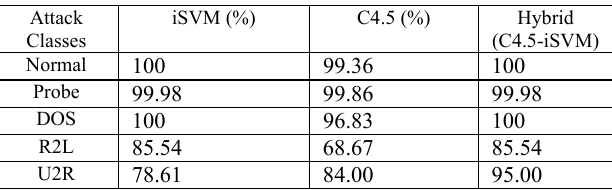
Table 7. Performance comparison of the